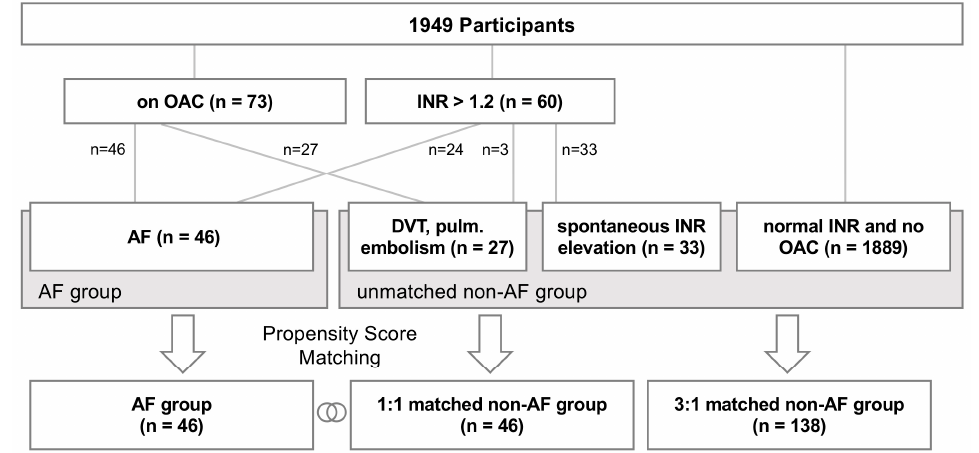
Figure 1. Patient Inclusion. In this retrospective study, 1949 participants in a CRC (colorectal cancer) screening program were included. Participants with AF (atrial fibrillation) were identified by investigation of detailed medical records those individuals under treatment with OAC (oral anticoagulation) and with elevated INR (international normalized ratio). This resulted in a cohort of 46 patients with AF, which were matched with 46 (1:1) and 138 (3:1) non-AF participants utilizing age- and gender-based propensity scores.